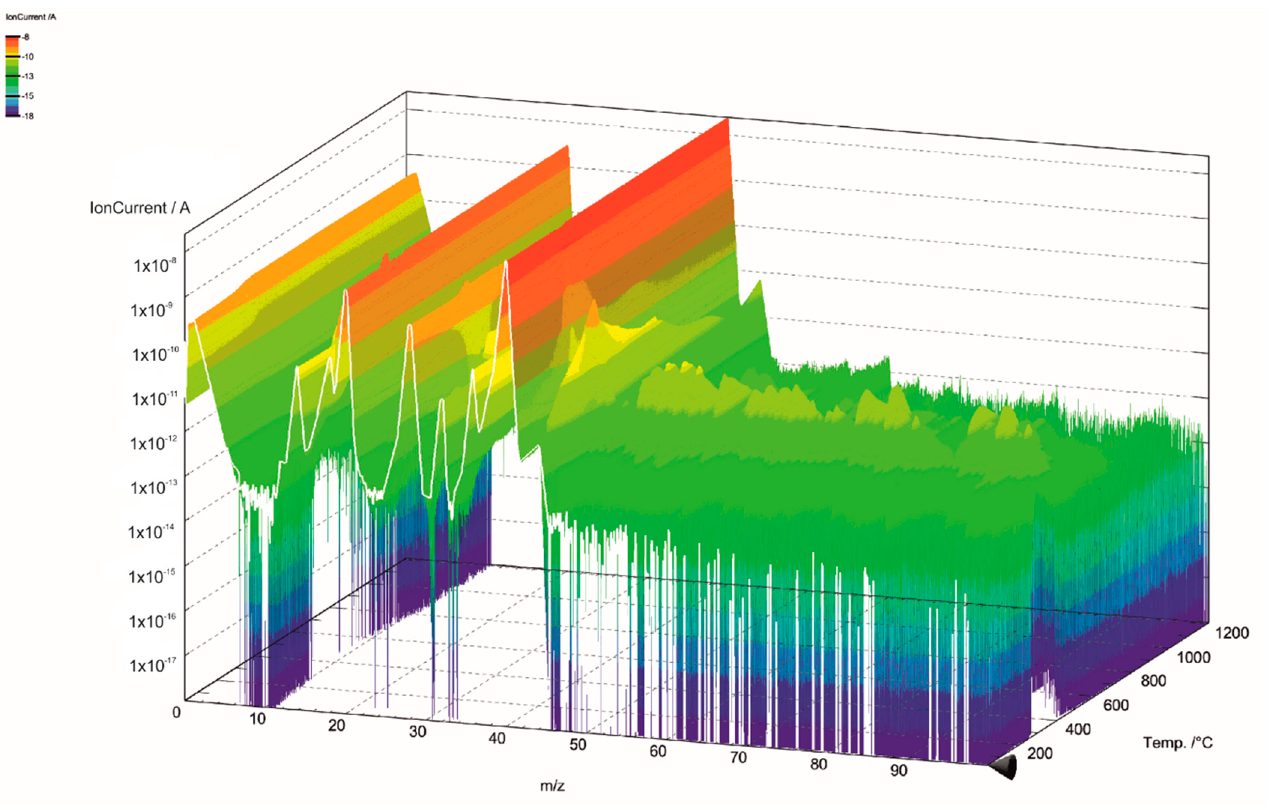
Figure 5. Mass spectra of lignin pyrolysis product gas in the m / z range of 0–100.